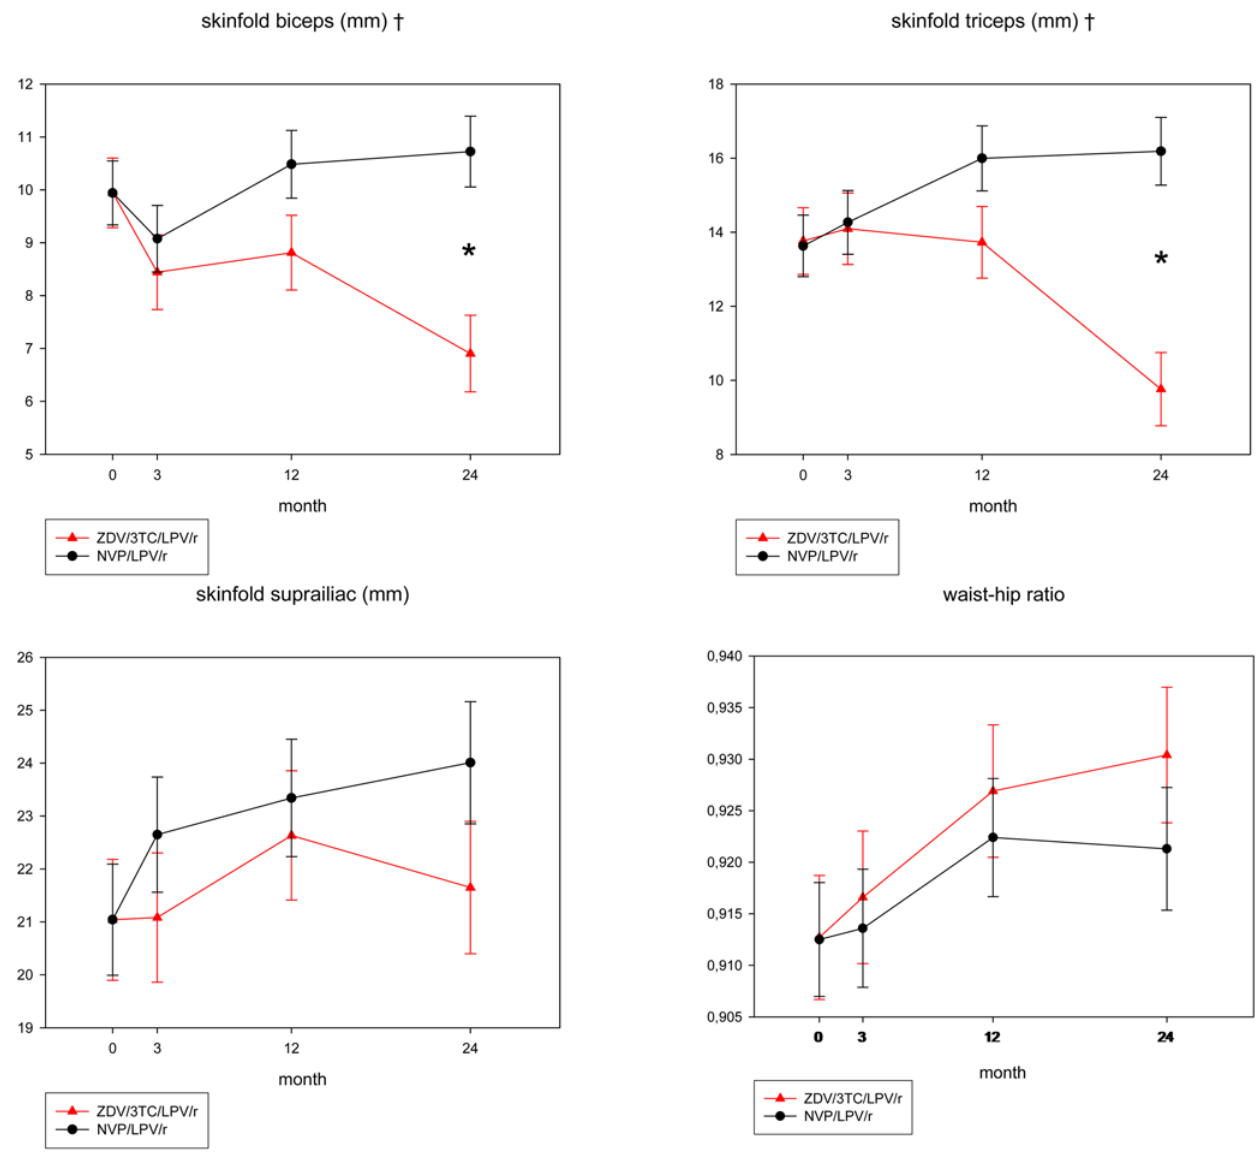
Figure 3. Body composition by anthropometry. Shown are estimated means 6 standard error of the mean (mixed model repeated measures analysis with correction for differences in baseline values). ZDV/3TC/LPV/r zidovudine/lamivudine/lopinavir/ritonavir. NVP/LPV/r nevirapine/lopinavir/ ritonavir. *p , 0.05 between groups at visit. { p , 0.05 overall difference between groups.